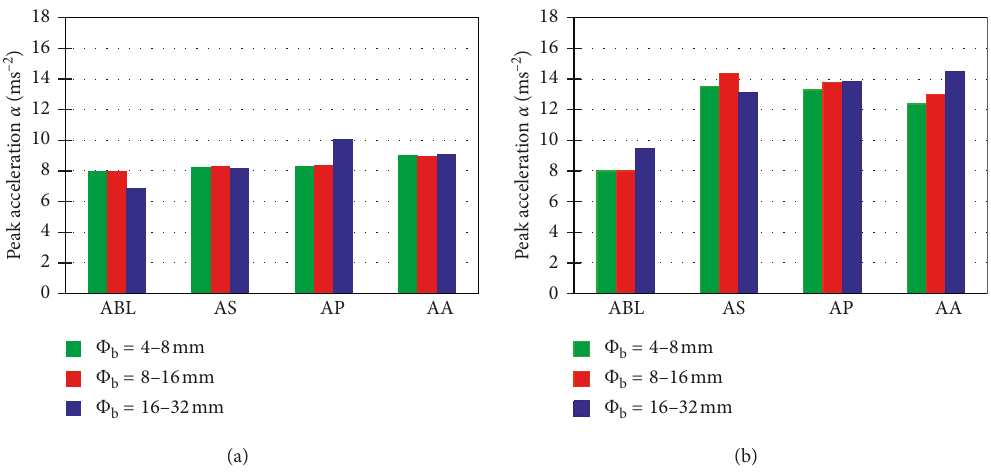
Figure 17: The effect of pebble fraction on peak horizontal acceleration a . (a) PGA � 0.2g. (b) PGA �